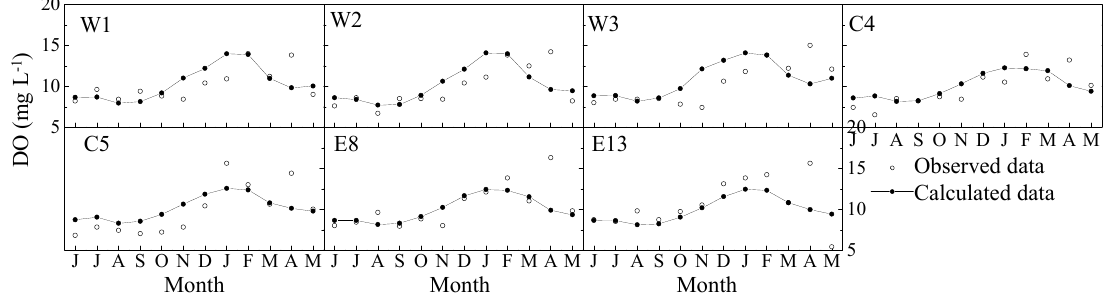
Figure 6. DO (mg L − 1 ) model (line + dots) and observed data (open dots) at 7 sites for June 2015 to